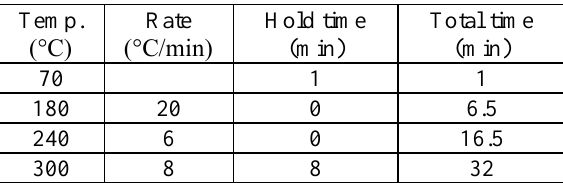
Table 1. Column oven temperature program